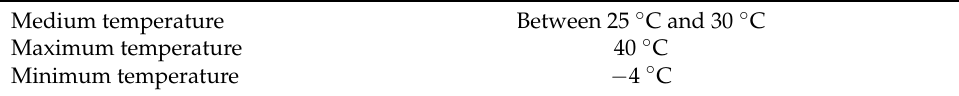
Table 9. Threshold temperature values for almond tree